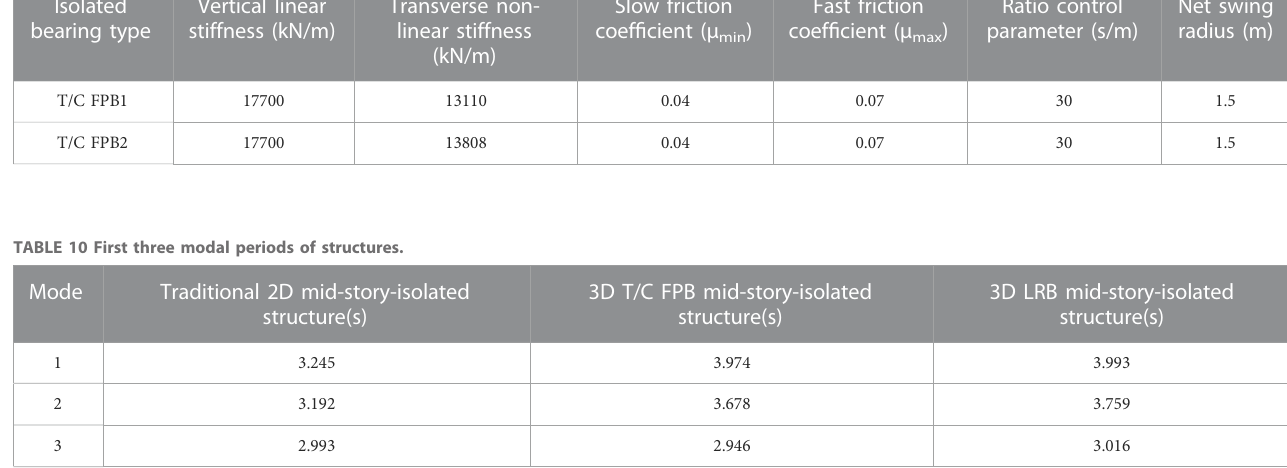
TABLE 9 Design parameters of the 3D T/C FPB isolated bearing. Isolated bearing type